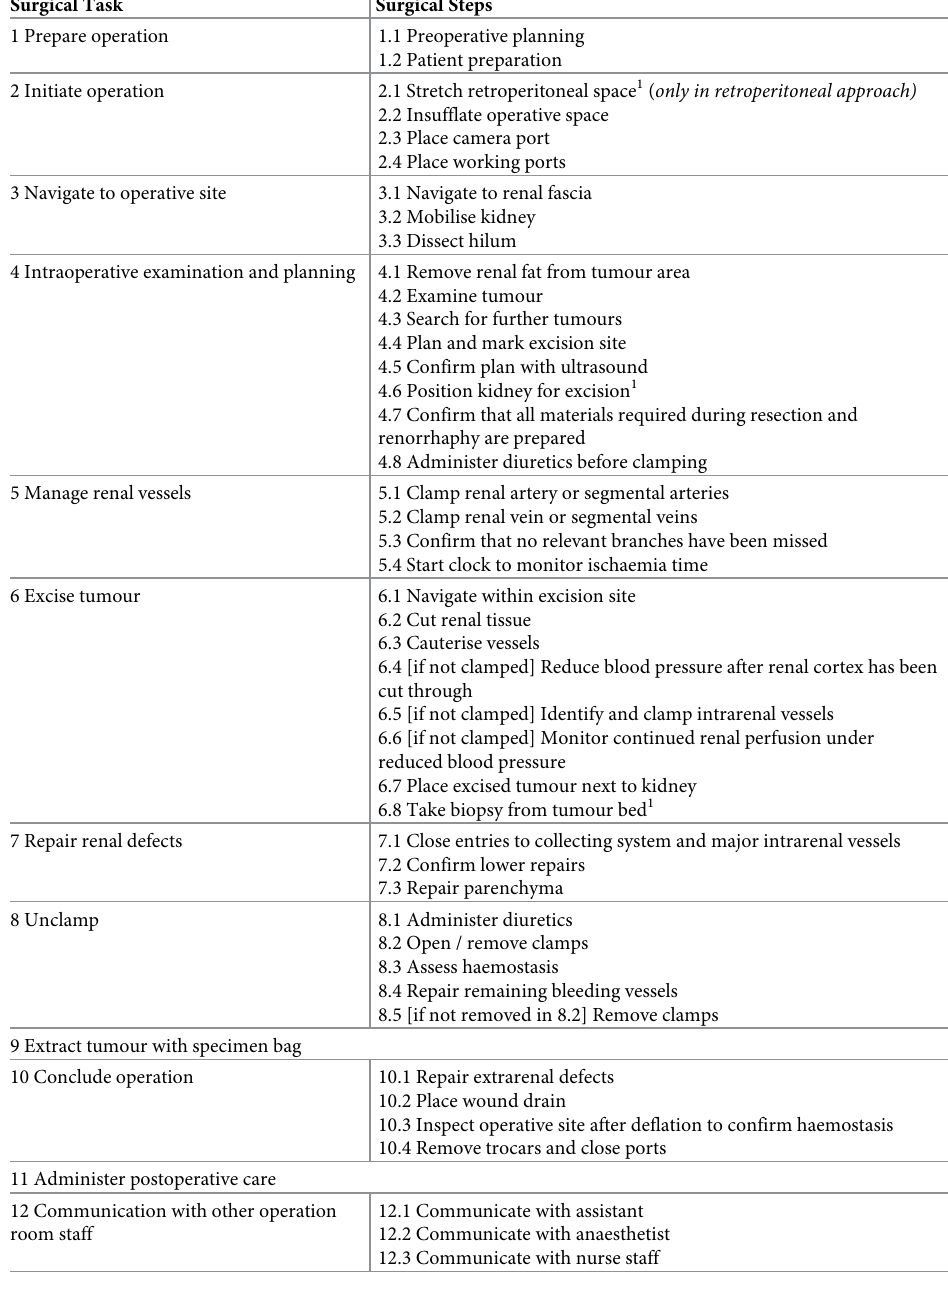
Table 1. Workflow of LPN/RPN in HTA format. Surgical Task Surgical